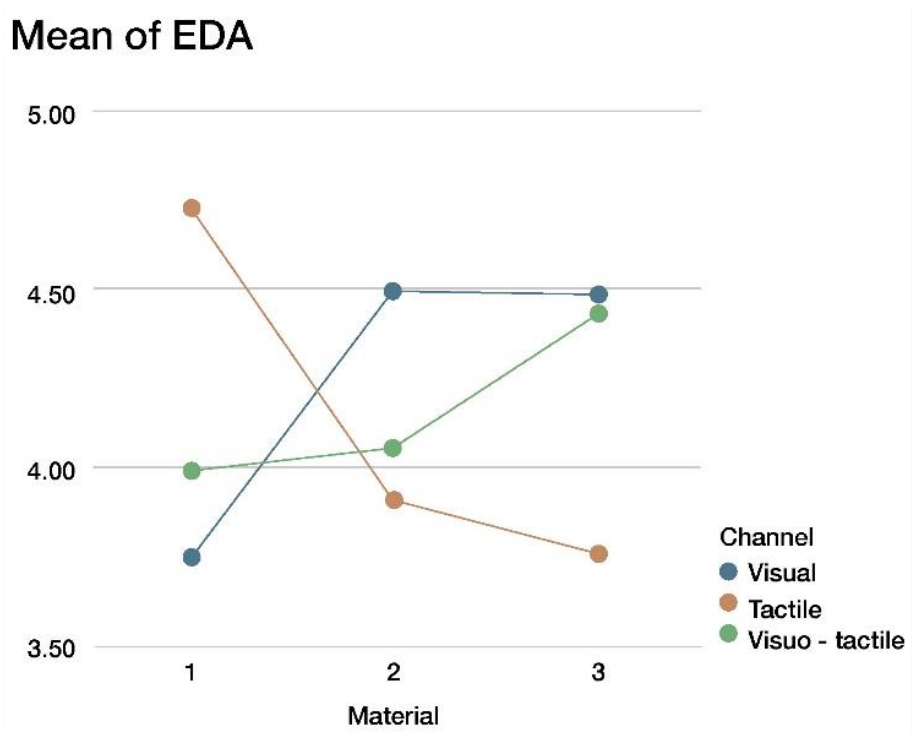
Figure 10. EDA response based on material and presentation channel.